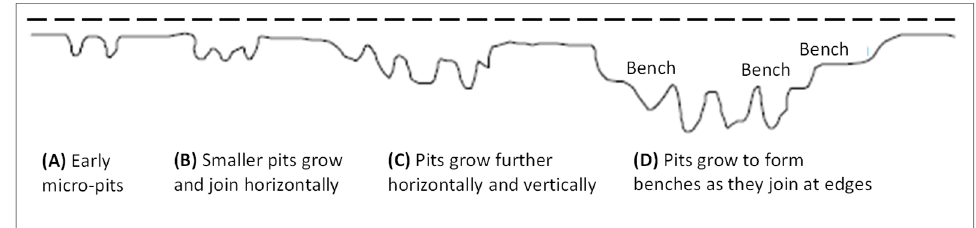
Figure 3. Proposed model of pitting growth [33].